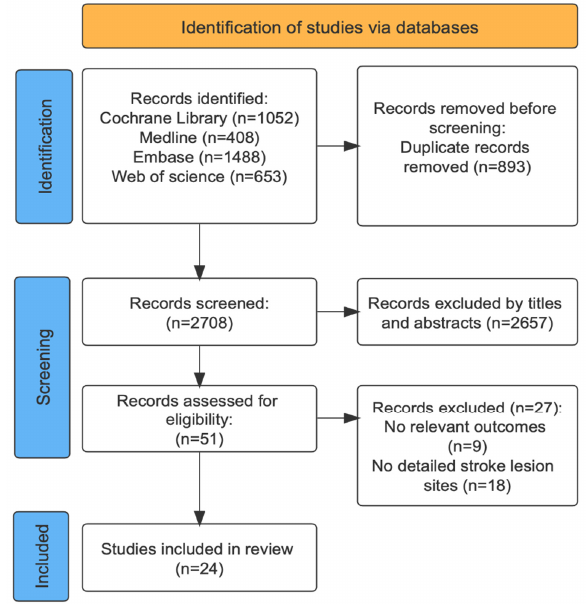
Figure 1. The PRISMA flow diagram.